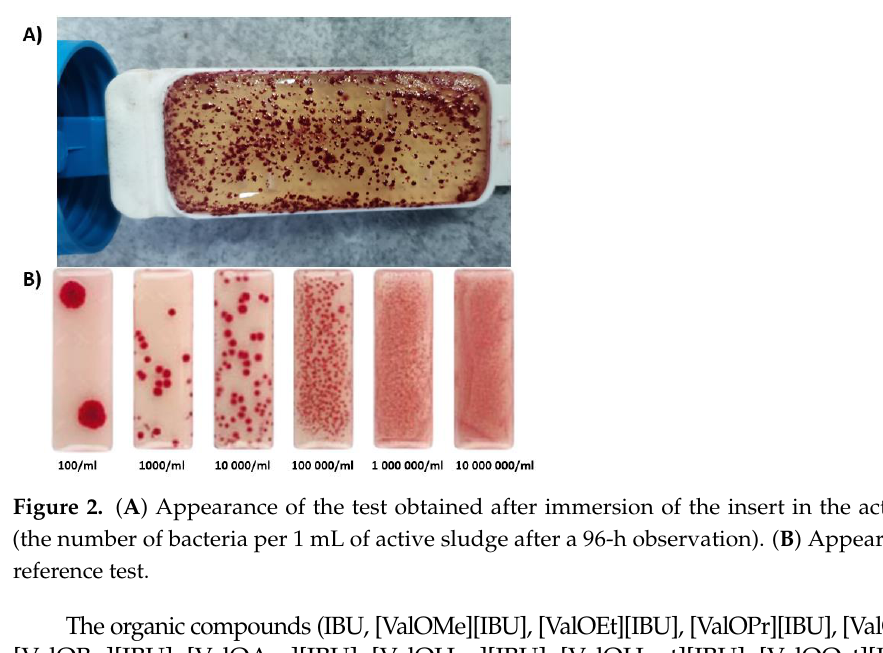
Figure 2. ( A ) Appearance of the test obtained after immersion of the insert in the active sludge (the number of bacteria per 1 mL of active sludge after a 96-h observation). ( B ) Appearance of the refer- ence test.